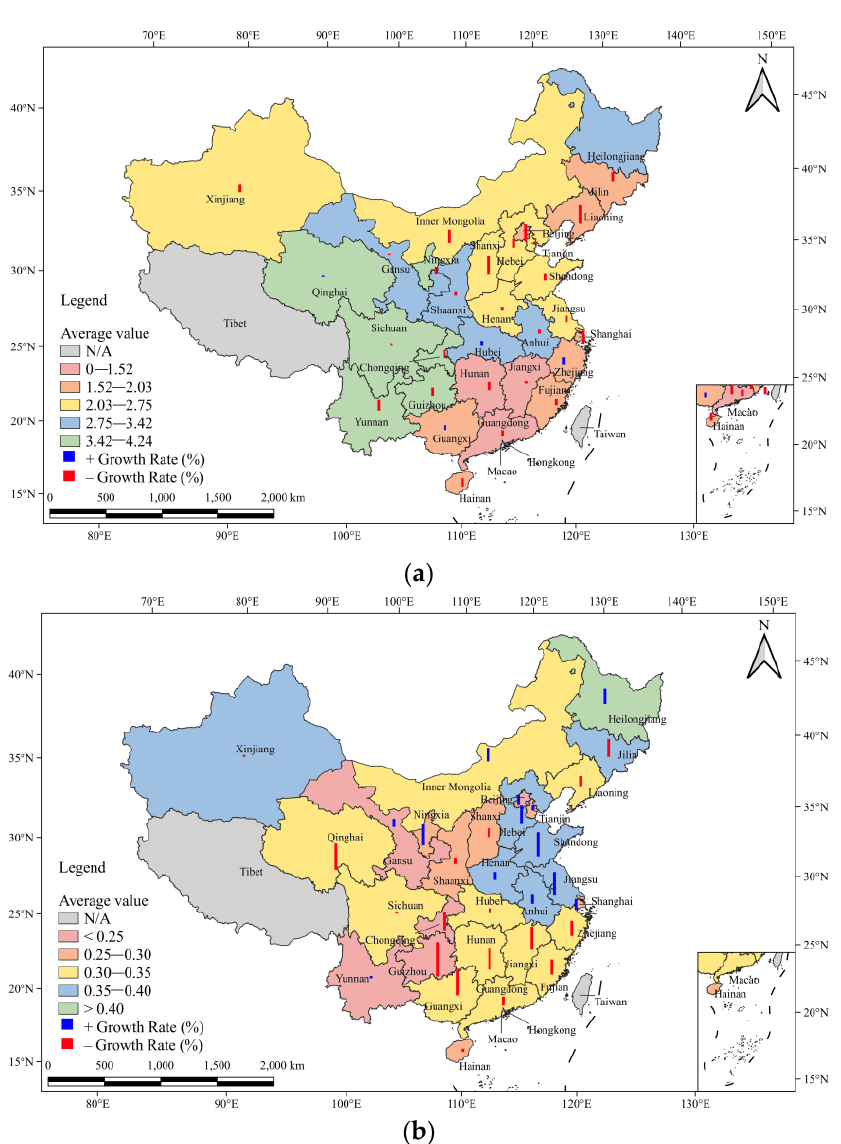
Figure 1. Regional characteristics and growth of decentralized food crop cultivation and WLF nexus, 2003 – 2019. ( a ) Decentralized food crop cultivation; ( b ) WLF nexus. 2003–2019. ( a ) Decentralized food crop cultivation; ( b ) WLF